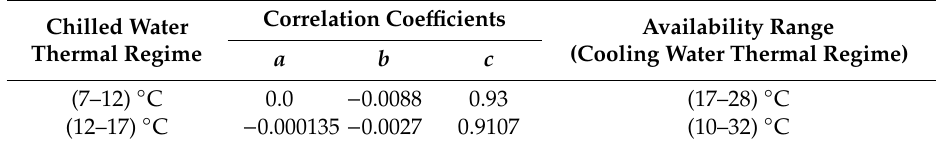
Figure 16. Variation of COP with the cooling water temperature and with hot water temperatures.